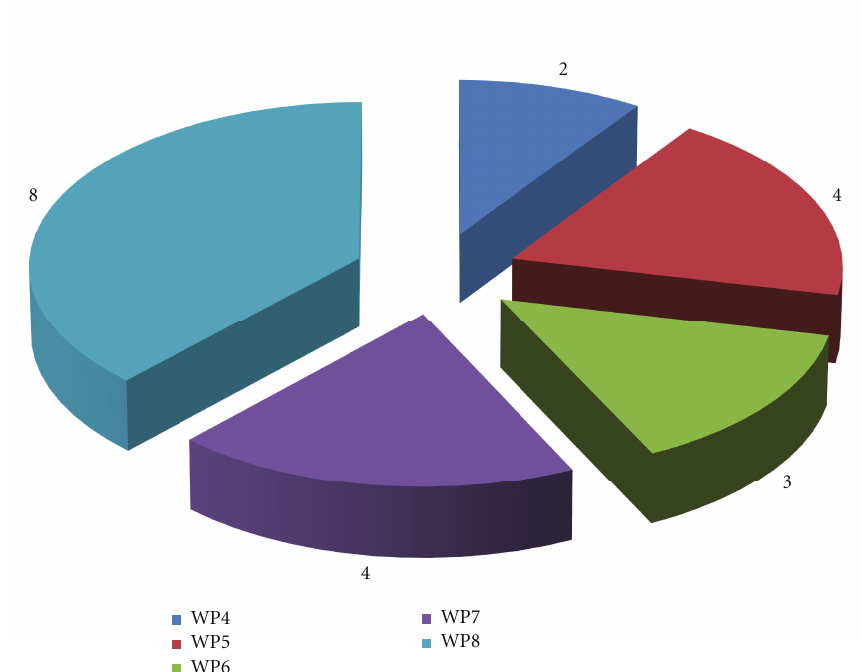
Figure 4: Distribution of the SARNET2 MOB